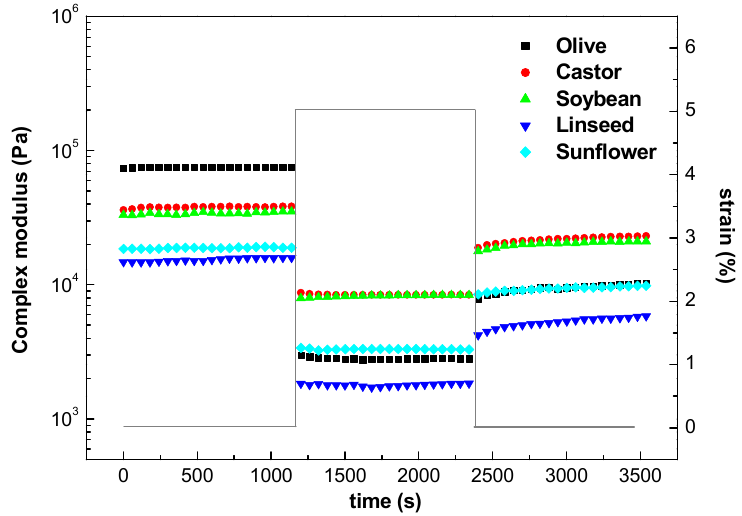
Figure 5. Complex modulus (G*) decay, at frequency of 1 Hz, after changing shear strain from the linear to the nonlinear viscoelastic region and further recovery when the former shear strain is re-imposed for the evolution of complex modulus for oleogels formulated with different vegetable oils.